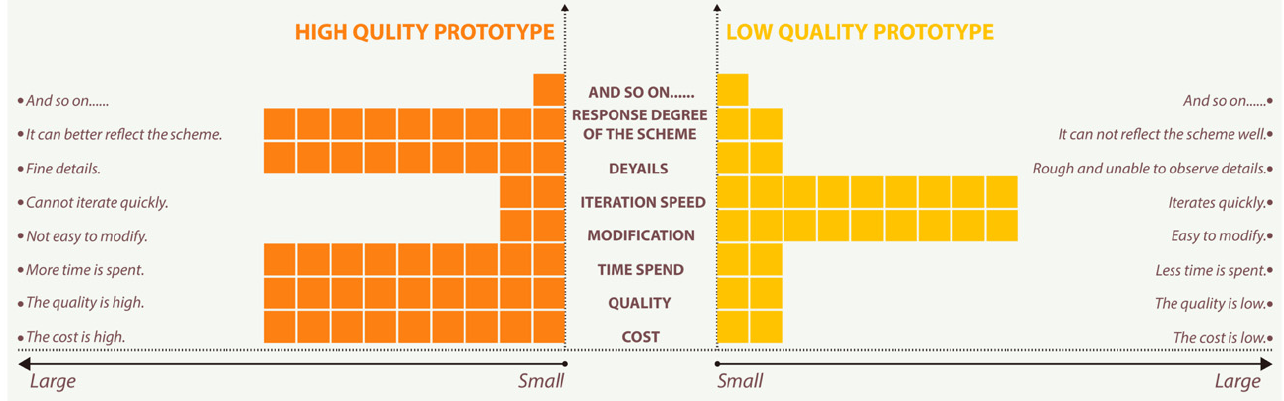
Figure 16. Examples of classification and characteristics of prototypes.